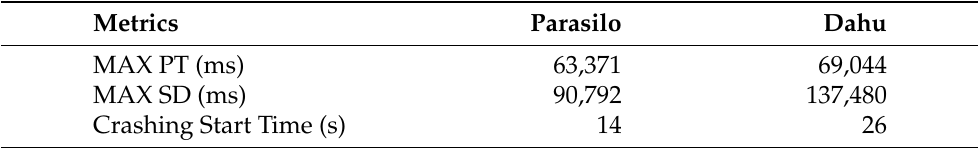
Table 7. Performance Crashing Indicators of Stateful SUMServer Application—Pipeline 2 without